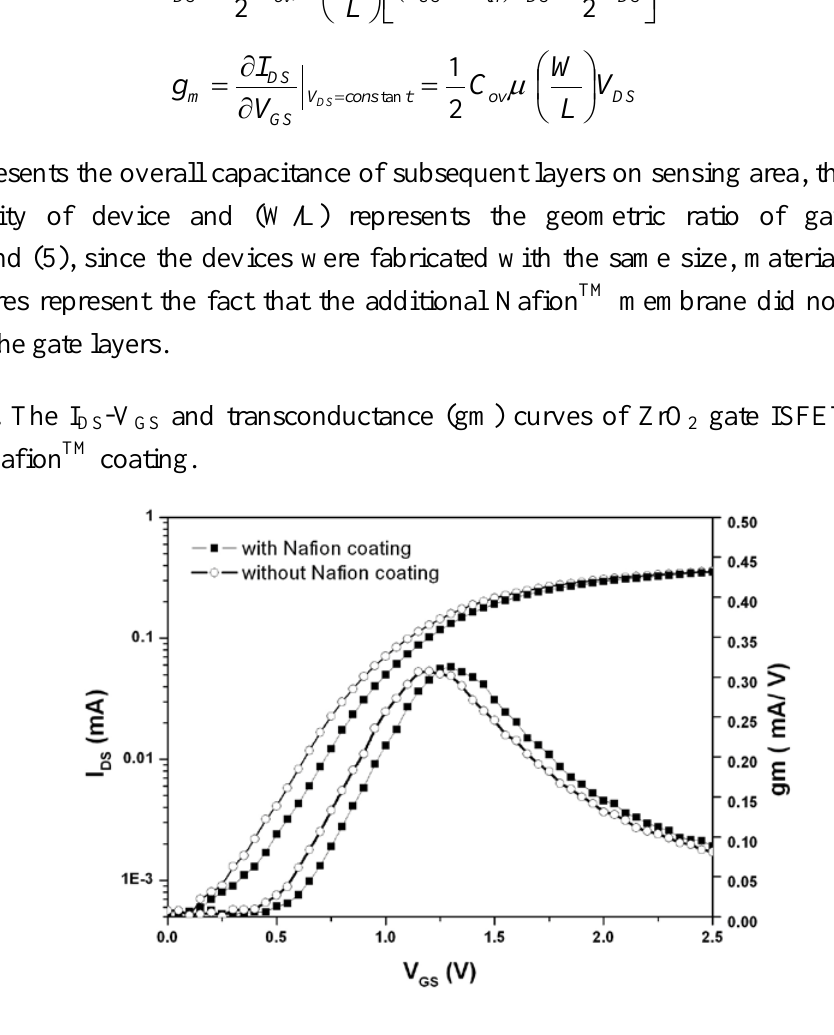
gate ISFETs with and 2